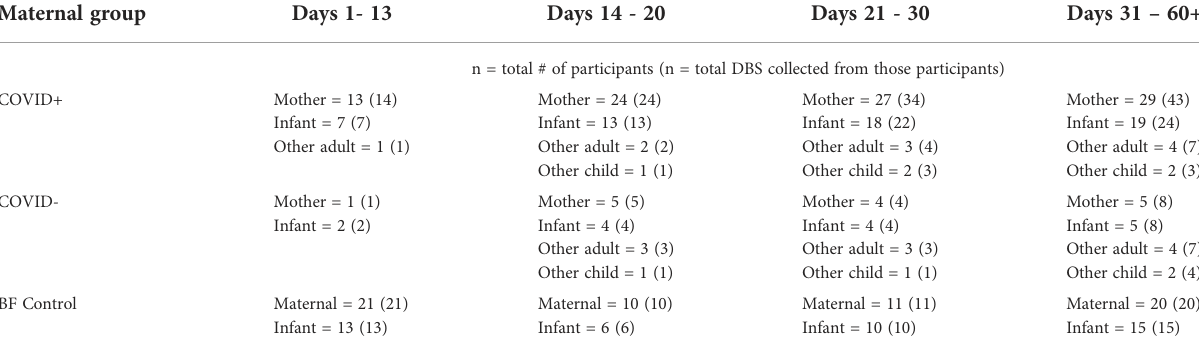
TABLE 3 Count summary of dried bloods spots (DBS) analyzed per enrollment group, participant category, and time since maternal start date ( fi rst day of reported maternal symptoms or PCR test for COVID+/- groups, and days since enrollment date for BF control group). Maternal